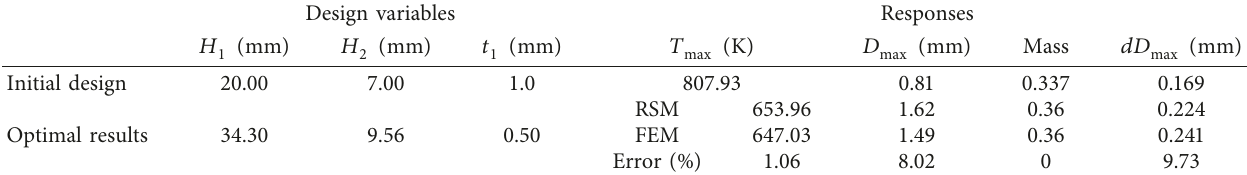
Table 10: 1st stage optimal results.